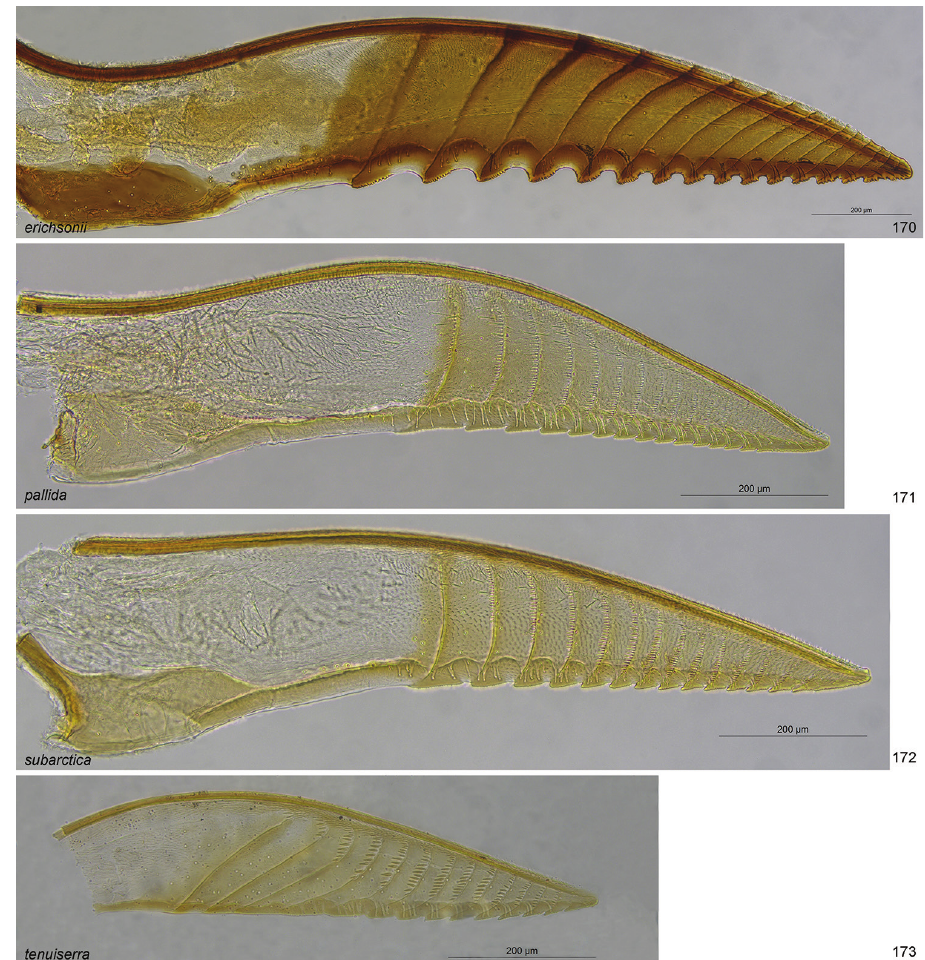
Figures 170–173. Lancets of Pristiphora . 170 erichsonii DEI-GISHym20807 171 pallida DEI- GISHym20845 172 subarctica , holotype of pseudosaxesenii 173 tenuiserra